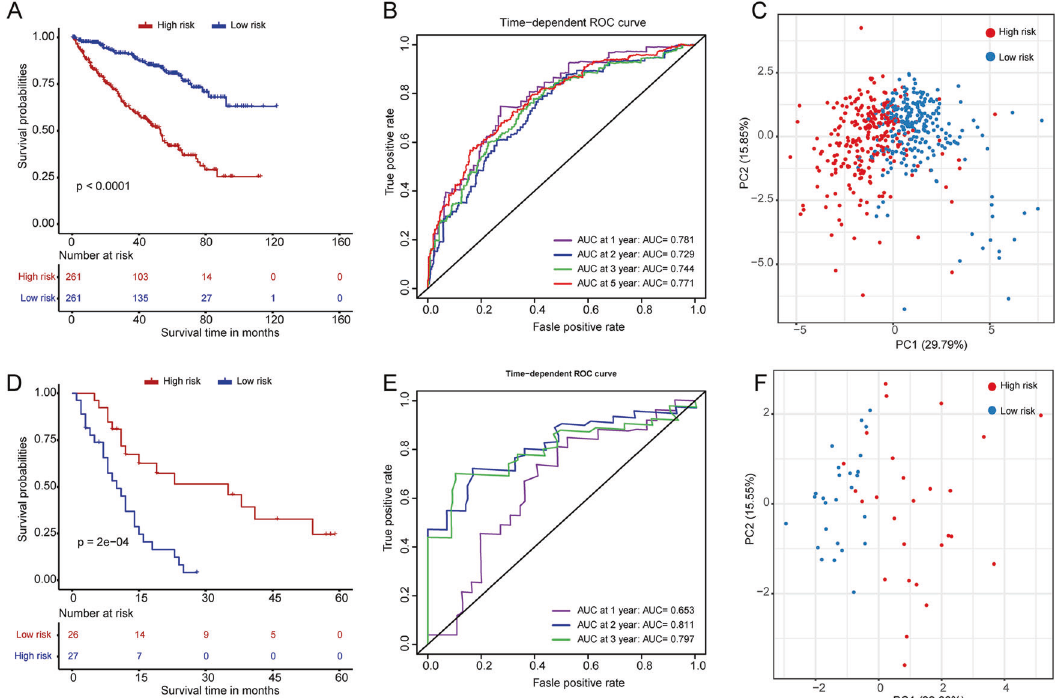
Fig. 5 Construction and validation of a costimulatory molecule-based prognostic signature. Kaplan – Meier curves for prognosis evaluation in TCGA dataset ( A ) and E-MTAB-3267 dataset ( D ). Time-dependent receiver operating characteristic curves for the sensitivity and speci fi city of prognosis evaluation in TCGA dataset ( B ) and E-MTAB-3267 dataset ( E ). Principal component analysis for the evaluation of distribution patterns for high-risk and low-risk patients in TCGA dataset ( C ) and E-MTAB-3267 dataset ( F